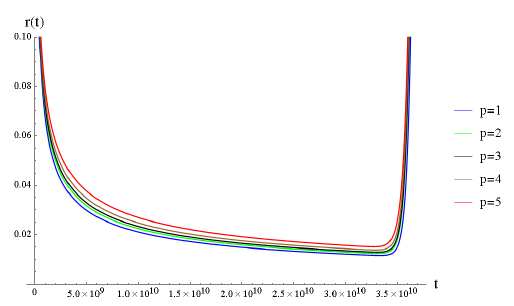
Figure 4. Tensor/scalar ratio.